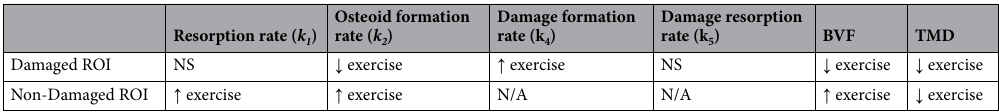
Table 2. Summary of how the steady-state rate constants, mineralized bone volume fraction, and tissue mineral density changed with exercise intensity in the two regions of interest (ROI). NS indicates no significant relationships were observed and N/A indicates the relationships were not calculated. The relationships between BVF and TMD in the two ROIs is described in Shaffer et al., 2022. Note: primary mineralization rate ( k 3 ) was